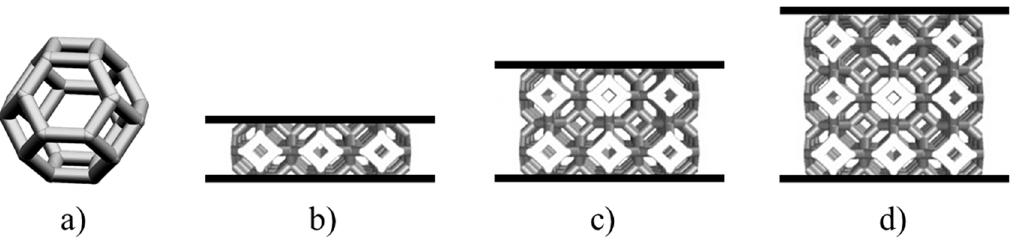
Figure 5. Geometry of the lattice structure investigated in this work: ( a ) Kelvin unit-cell; ( b ) 1-layer lattice; ( c ) 2-layers lattice; ( d ) 3-layers lattice.